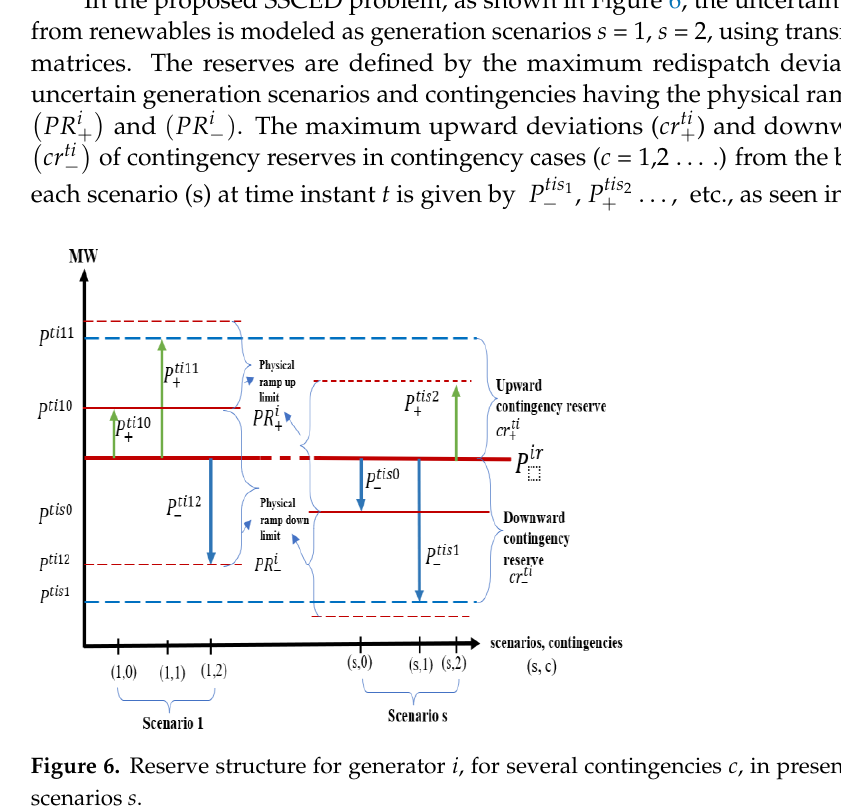
Figure 5. Load-following ramping reserves and ramping in the normal state [15].